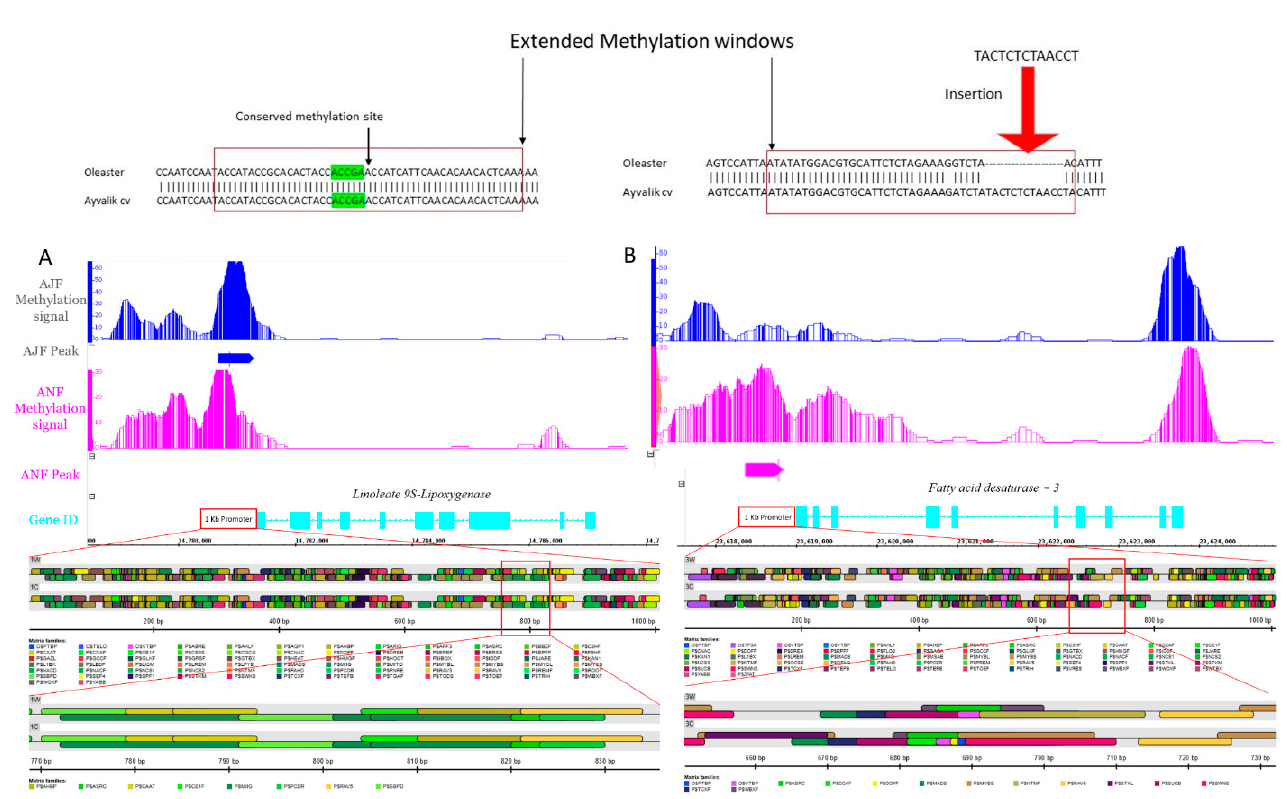
Figure 3. Comparative promoter analysis of methylated putative genes responsible for the sensory and organoleptic qualities of olive oil between wild and cultivated olives. ( A ): linoleate 9S-Lipoxygenase. ( B ): Fatty acid desaturase FAD3. Colored boxes indicate the cis-elements in each promoter region. Zoomed parts show conserved, gained, and/or lost cis-elements at the methylation window between wild and cultivated olives. AJF: Ayvalik July fruit, ANF: Ayvalik November fruit, DNF: Delice November fruit sample and DJF: Delice July fruit sample.